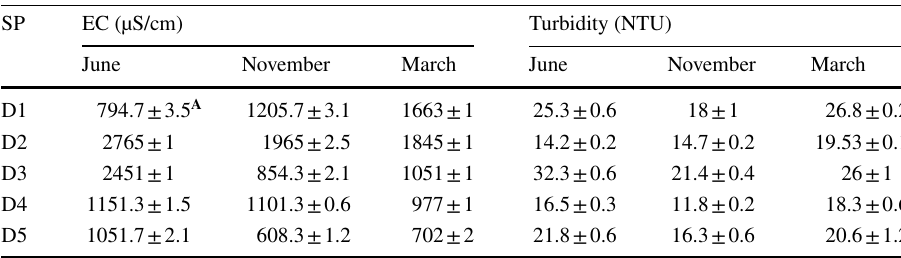
SP sampling points, D drain, A (mean ± SD), n =